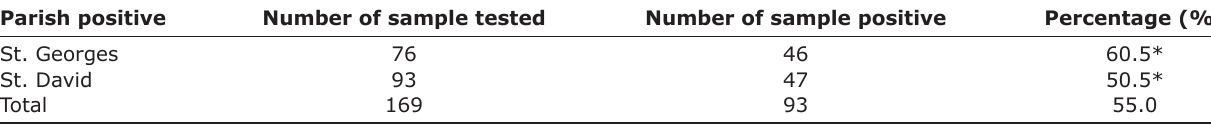
Table-1: Prevalence of Giardia antibody (anti-GD) in serum of brown rats from Grenada according to Parish. Parish positive